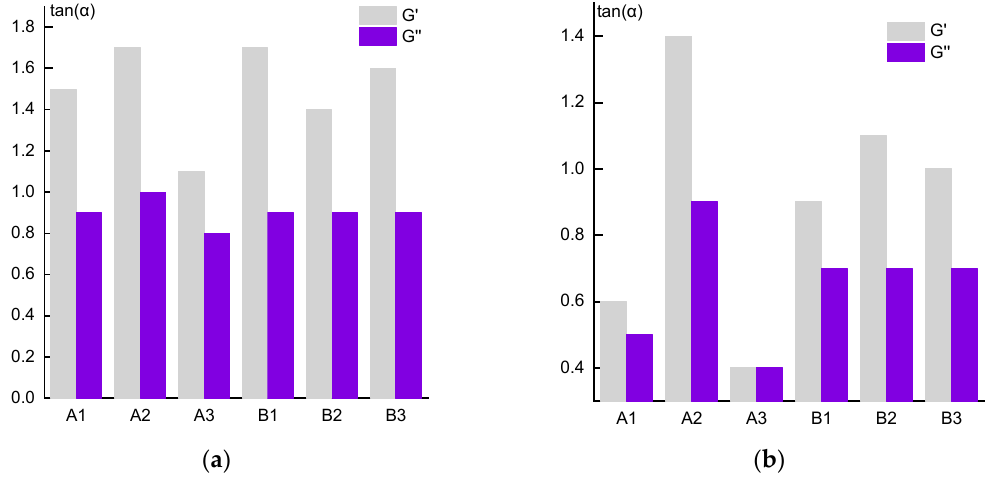
Figure 9. The slope values of the G ’and G’’ frequency dependences for the 10% solutions ( a ) and 20% solutions ( b ) in the region of segmental mobility.